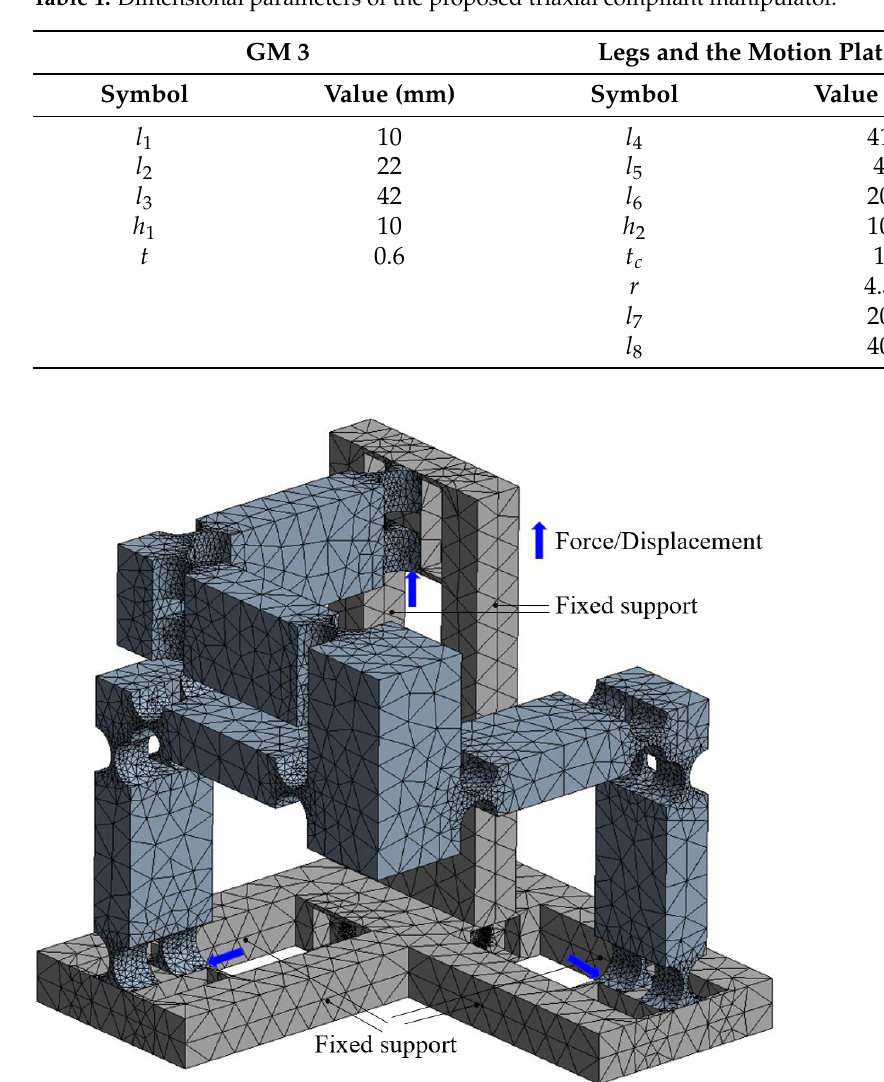
Figure 6. Details of the FEA